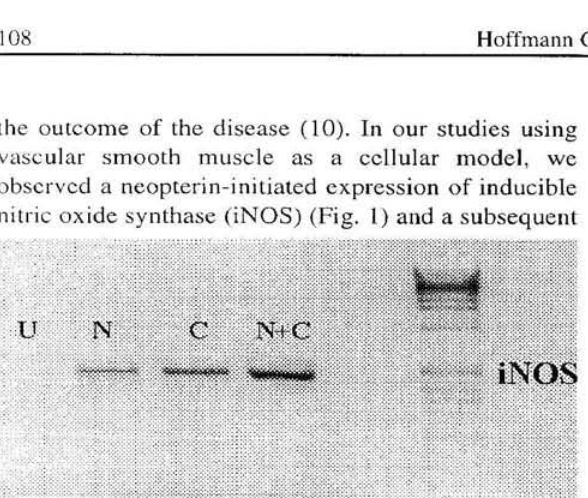
I. Qualitative analyses of inducible nitric oxide synthase (iNOS) gene expression in vascular smooth muscle cells following a 6-h incubation with neopterin (ΊΟ μΜ), a combination of tumor necrosis factor-α (500 U/ml) and interferon-γ (100 U/ml) (C), and a mixture of neopterin plus cytokines (N+C). U represents unstimulated controls.